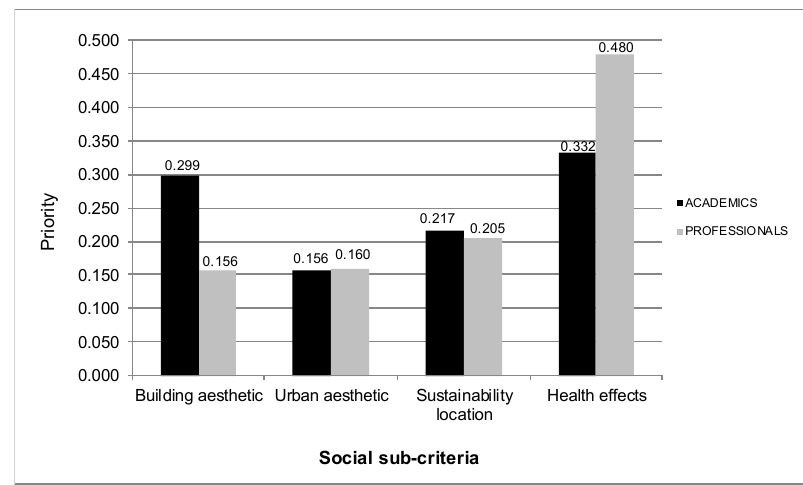
Figure 6. Priorities assigned to “Social” sub-criteria by Academics and Professionals.